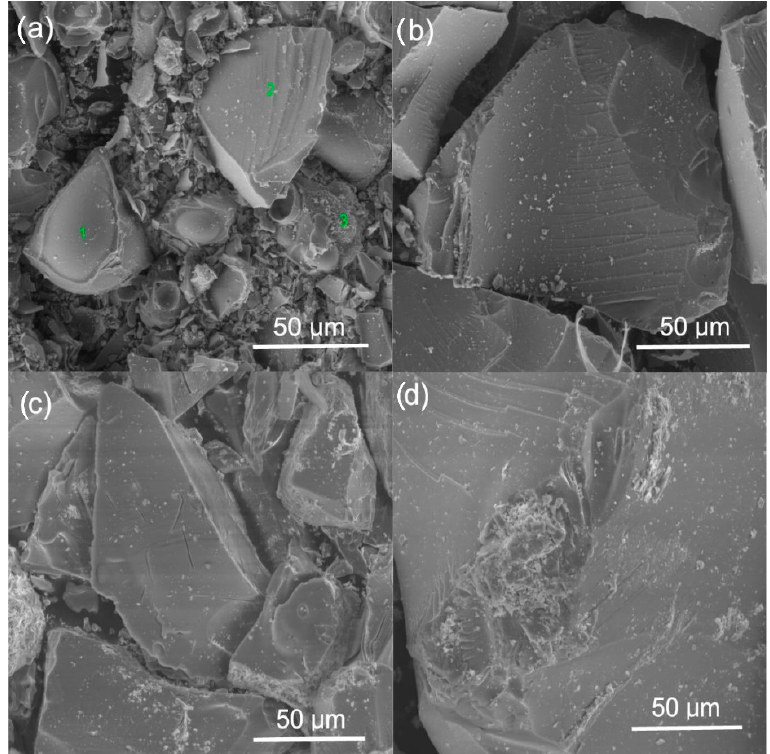
Figure 7. SEM images of: ( a ) 1T gel synthesized using zirconium (IV) n-propoxide; ( b ) 4T gel synthesized using zirconium (IV) n-propoxide; ( c ) 1C gel synthesized using zirconium (IV) acetate and ( d ) 4C gel synthesized using zirconium (IV) acetate. All gels were annealed at 1200 °C in air.